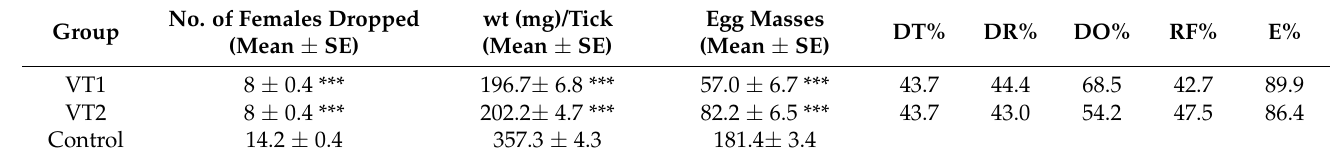
Table 7. Entomological parameters of ticks that fed on VT1- and VT2-immunized group of rabbits.